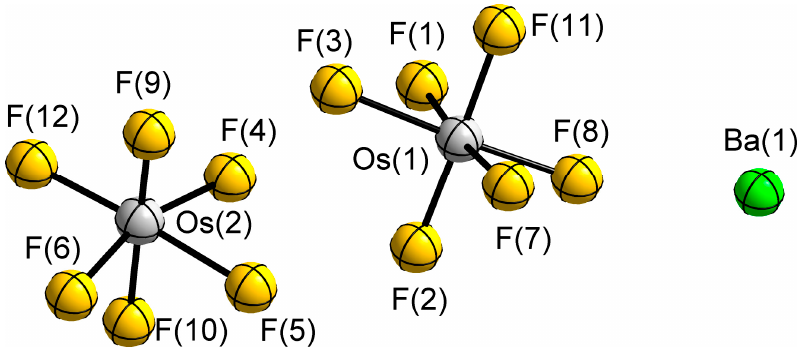
Figure 3. Asymmetric unit of Ba(OsF 6 ) 2 . Atoms are shown with isotropic displacement parameters, F atoms with fixed ones.